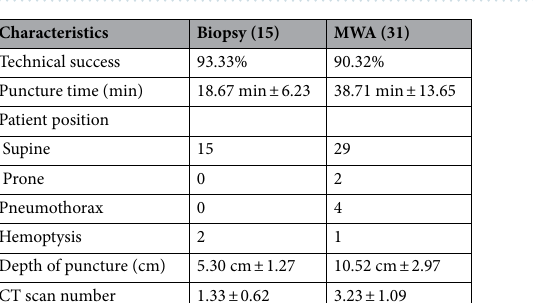
Figure 4. A clinical MWA puncture case by applying a fine needle-mediated breathing control technique for a 59-year old male who had esophageal carcinoma history. ( A ) Routine CT scan showed the feature of the lesion; 1.7 cm × 1.6 cm × 2.0 cm in size and located at posterior basal segment of lower lobe of the left lung. ( B ) A 23G fine needle was inserted into the lung as breathing indicator, showing the needle paralleled to the CT cross section and the whole length of needle visible in the image. ( C ) With the reference of the fine needle, a MWA electrode was inserted to the distal margin of the lesion. ( D ) Post-ablation CT scan observed no obvious complications.